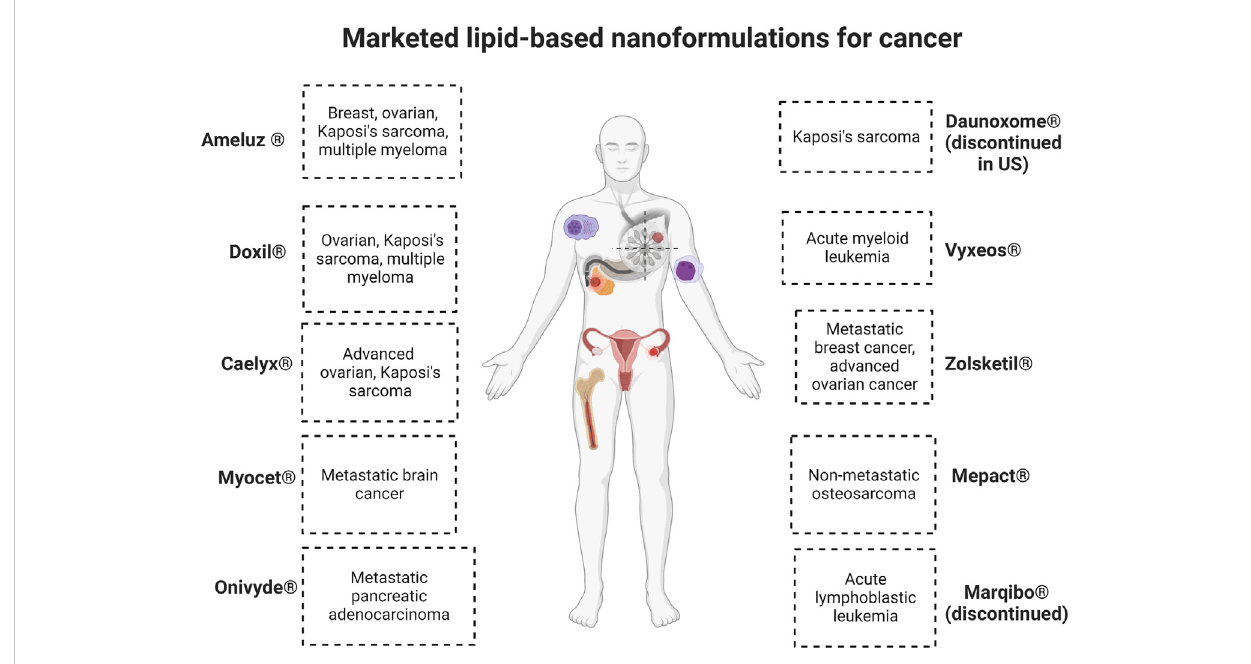
FIGURE 2 Commercialized lipid-based nanoformulations. Created with